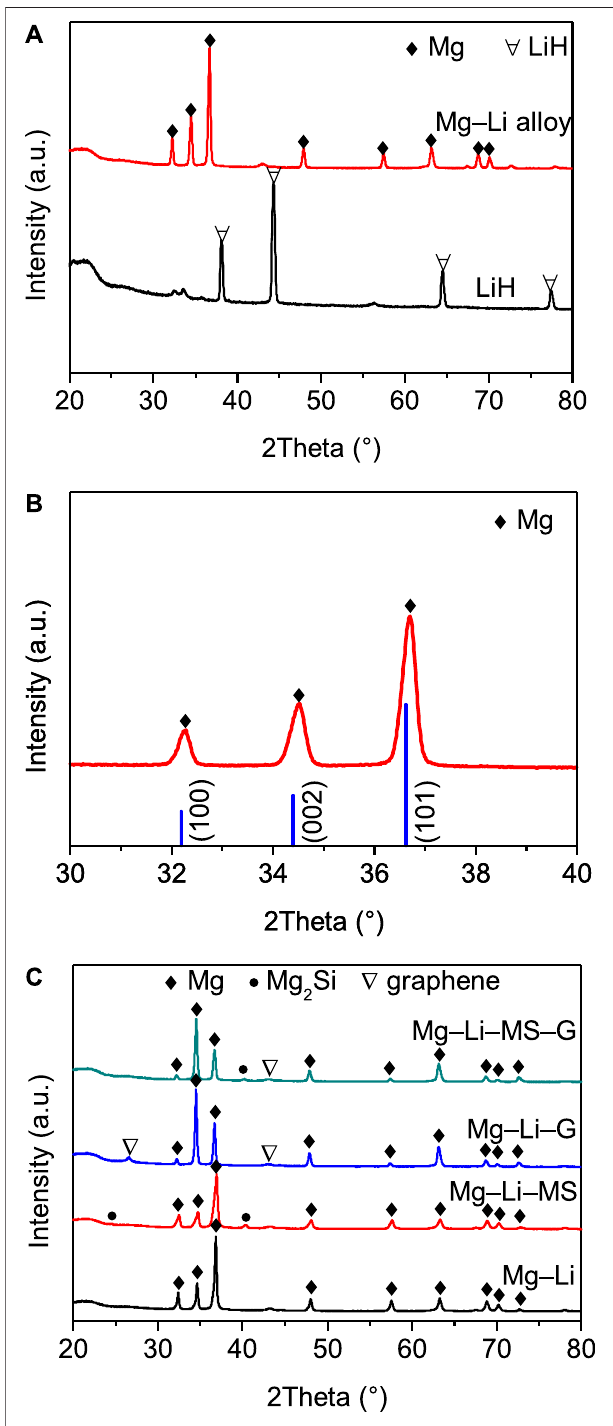
FIGURE 1 | (A) XRD patterns of as-received LiH and Mg − Li alloy after sintering treatment; (B) Expanded XRD patterns of Mg − Li alloy after sintering treatment in 2Theta rage 30 – 40 ° ; (C) XRD patterns of as-milled Mg − Li, Mg − Li − MS, Mg − Li − G, and Mg − Li − MS − G composites.